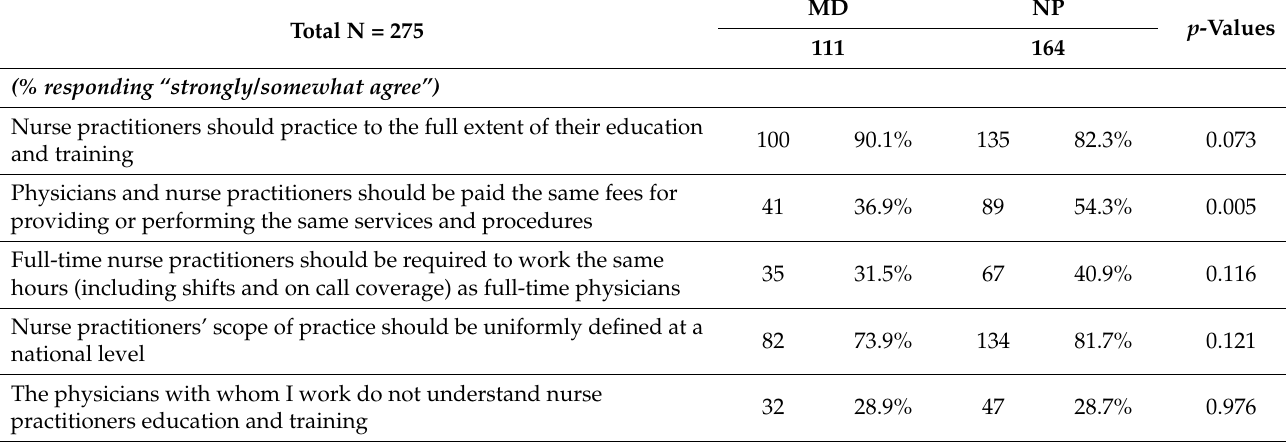
Table 5. Perceptions of NP Policy and Practice in